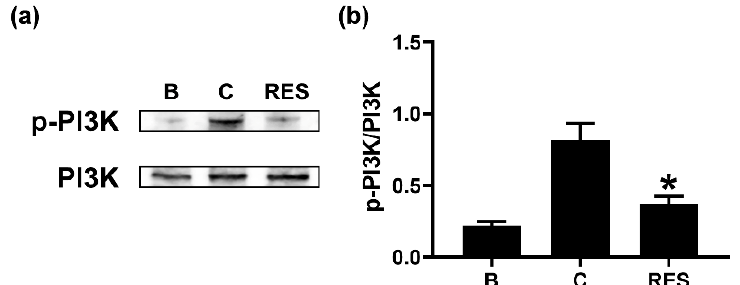
Figure 4. Effects of RES on the phosphorylation of PI3K in neutrophil-like dHL-60 cells. ( a ) dHL-60 cells (5 × 10 6 ) were exposed to RES (3 µM) for 1h, and then stimulated with GM-CSF (5 ng/mL) for 15 min. ( b ) The protein levels were quantitated by densitometry. B, PBS-added and unstimulated cells; C, PBS-added and GM-CSF-stimulated cells; RES, RES-added and GM-CSF-stimulated cells. Data are shown as the mean ± SEM of three independent experiments. * p < 0.05 vs. the PBS-added and GM-CSF-stimulated cells.